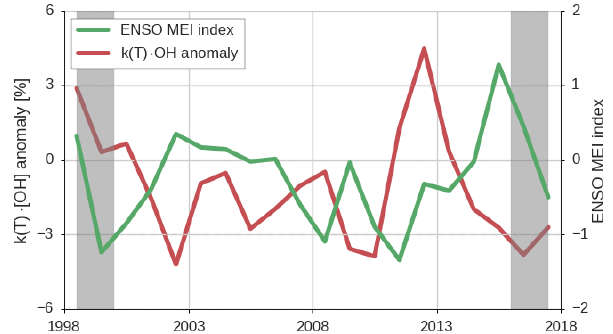
Figure 8. Variations in the annual mean MEI (right axis) and varia- tions in global, annual mean k(T ) · [OH] (left axis), as derived in the REF inversion. Gray bars indicate a spin-up and spin-down period of 1.5